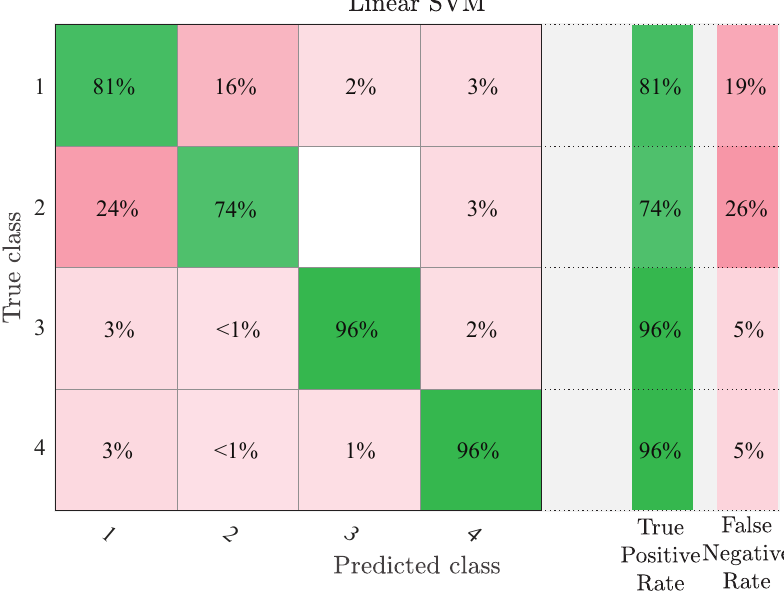
Figure 16. Confusion matrix of Support Vector Machine (SVM).